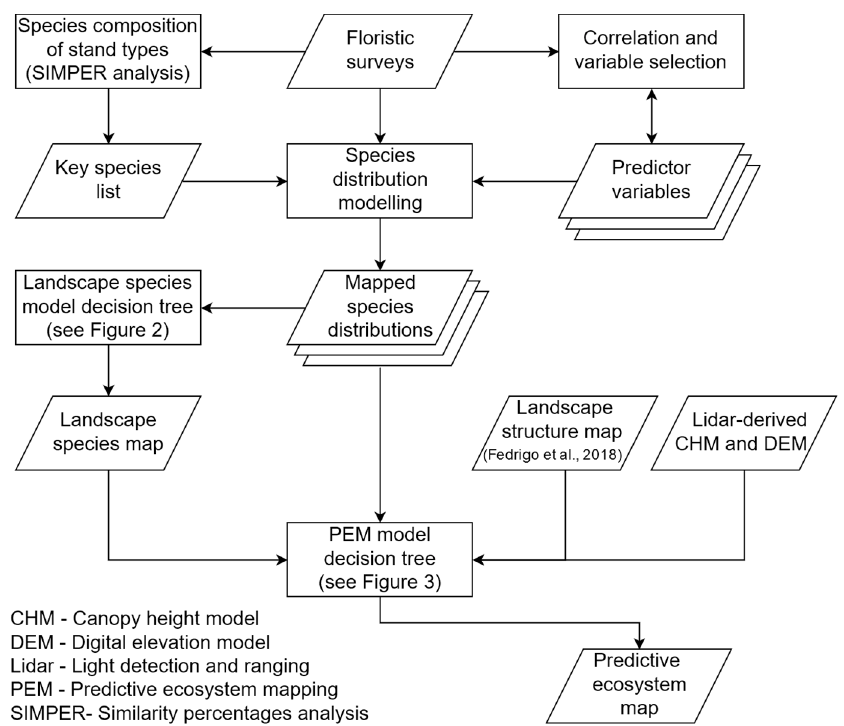
Figure 4. Methodological framework for predictive ecosystem mapping (PEM) by applying a series of rule-based decision trees to species distribution models, lidar-derived stand type classifications (i.e., landscape structure map; Fedrigo et al. [61]), a canopy height model and elevation data.